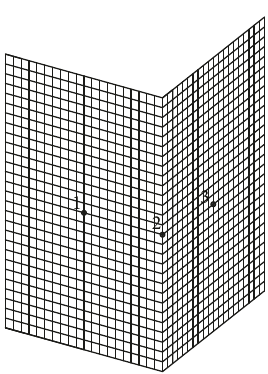
Figure 10: The locations of selected points.